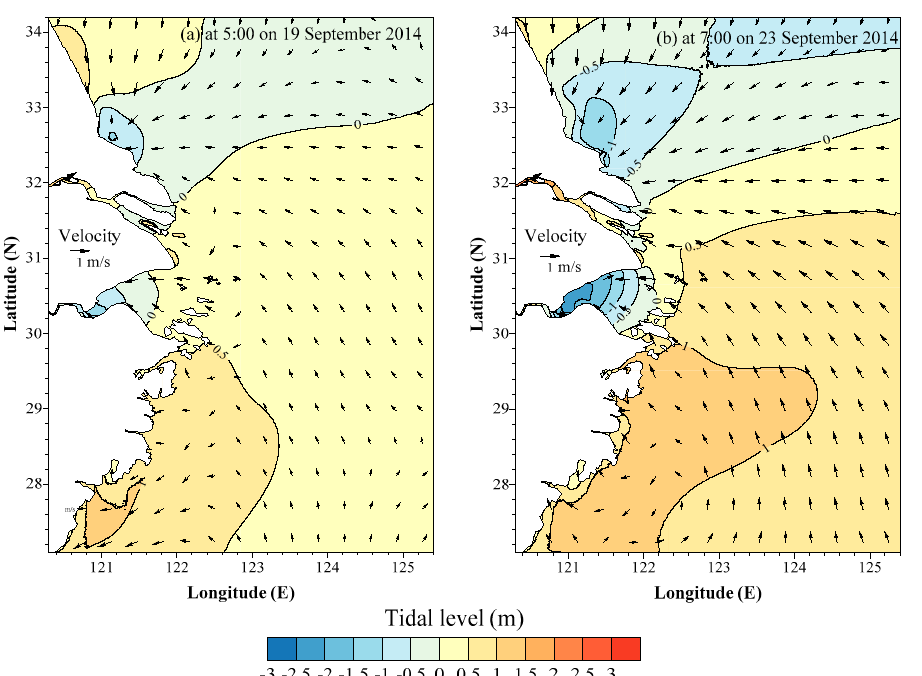
Figure 11. Tidal level contours and surface current velocity vector fields at 5:00 on 19 September ( a ) and at 7:00 on 23 September 2014 ( b ) with the strongest storm surge.